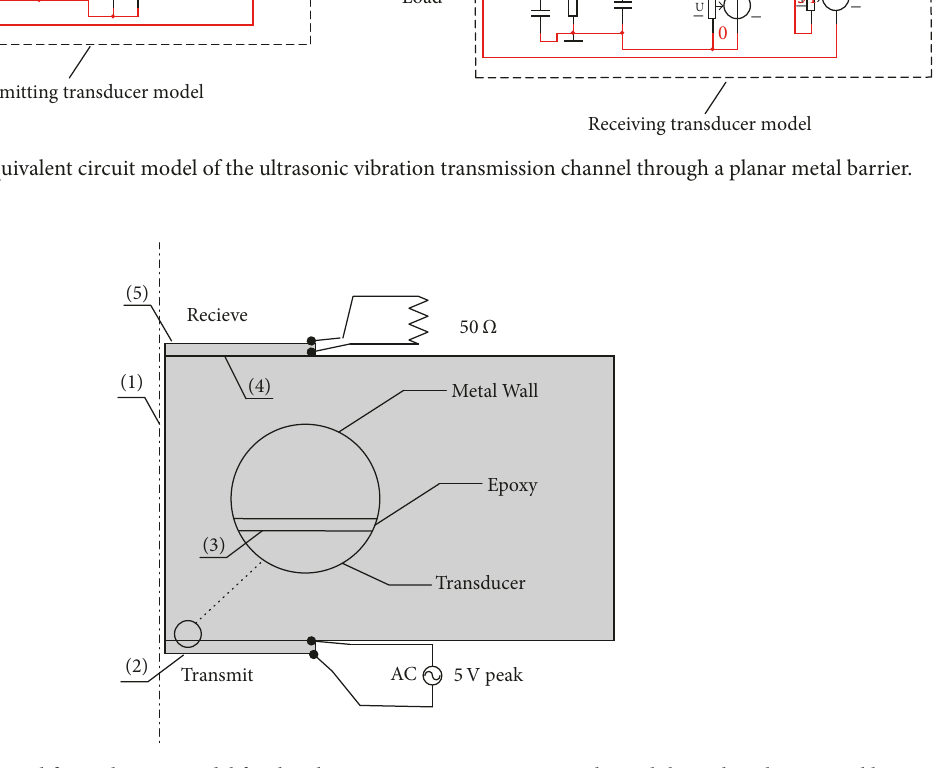
Figure 5: Two-dimensional finite element model for the ultrasonic energy transmission channel through a planar metal barrier.